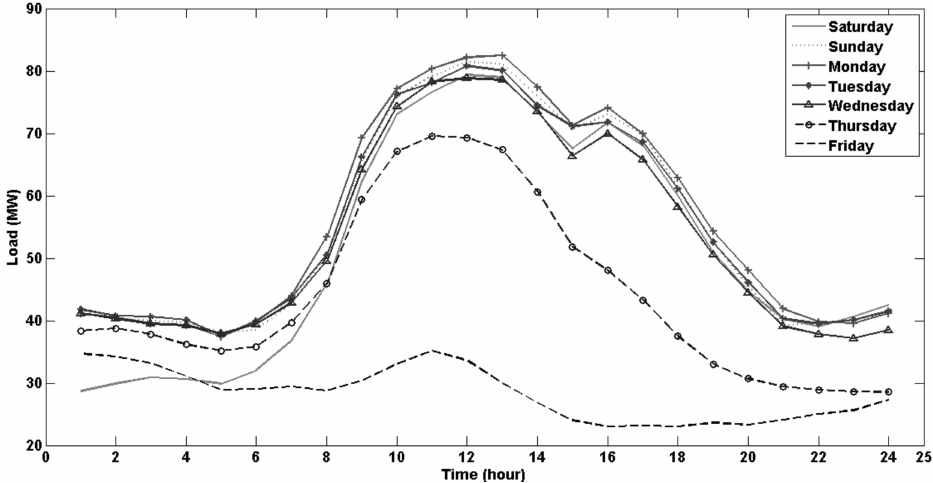
Figure 5. Hourly load curve of Shams Abad industrial zone in summer over a week.